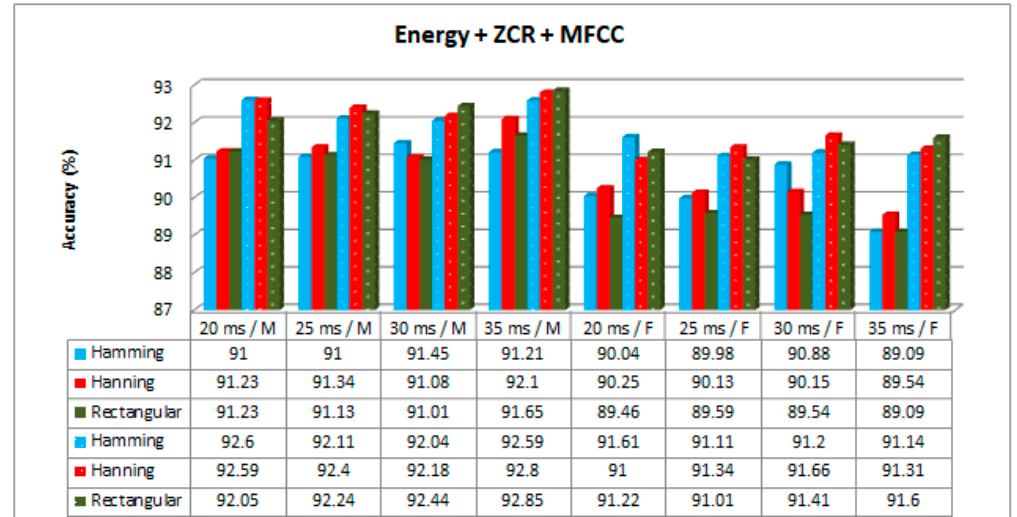
Figure 9. EZMFCC accuracy results without GRU-based training (no dotted bars) and with GRU-based training (dotted bars) using a CNN classifier for male (M) and female (F) speakers.